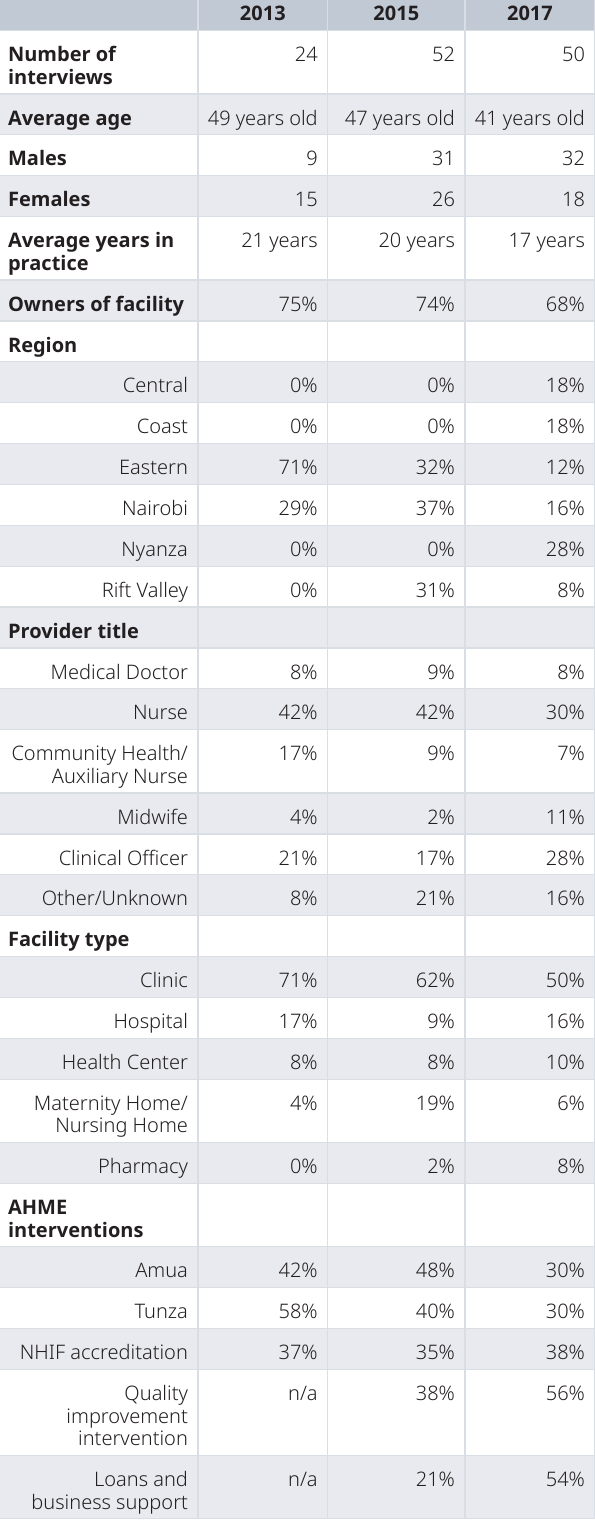
Table 1. Provider sample characteristics. NHIF=National Hospital Insurance Fund; AHME=African Health Markets for